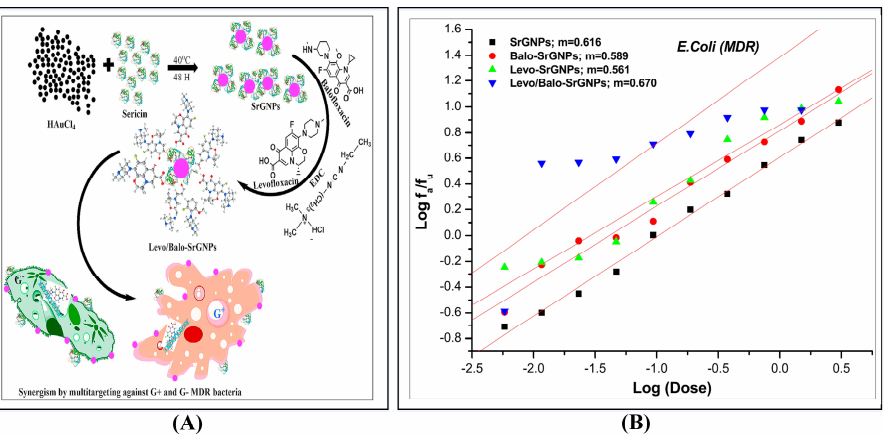
Figure 1. Application of SrGNPs in medicine [16]; ( A ) synergistic effect of levofloxacin, balofloxacin, and SrGNPs by targeting multi-targets; ( B ) median effect slope curve of Escherichia coli (MDR sclerotia). Reprinted with permission from Ref. [16]. Copyright 2020 Elsevier.